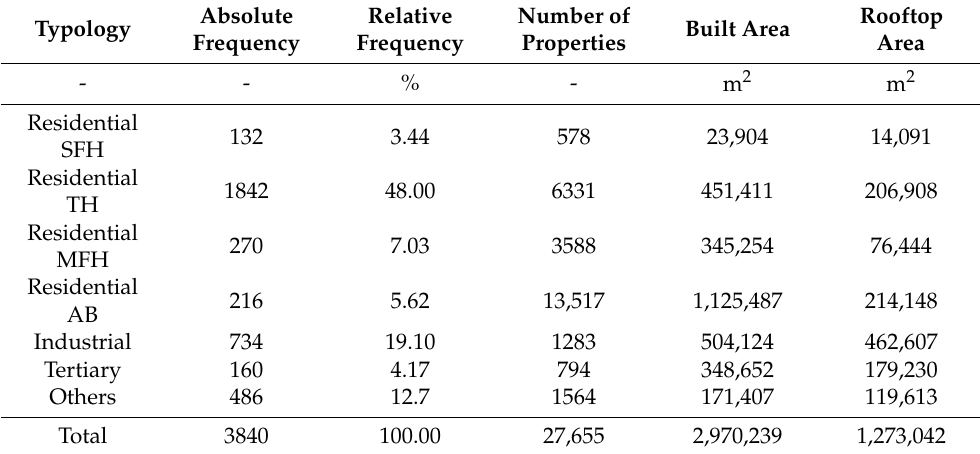
Table 1. Building stock of the municipality of Catarroja (Spain).